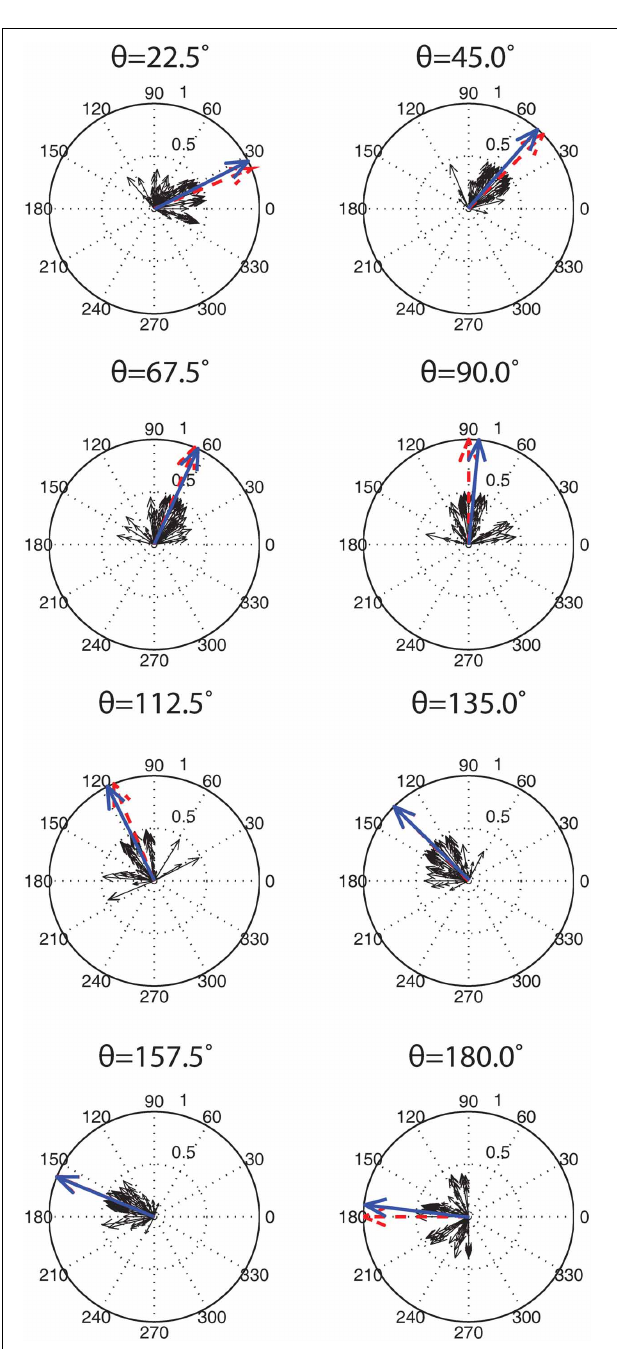
FIGURE 10 | Population decoding of eight test presentation angles. The test presentation angle θ , is shown above each population decoding figure. 100 simulation runs, each with identical parameter values but different training presentation orders, were conducted and the firing rates of the Exc group neurons were recorded. The individual responses of each of the 400 neurons (4 Exc neurons × 100 runs) are shown with solid black arrows. These individuals were summed to give a population vector (shown with a blue arrow) that was compared to the correct presentation angle (shown with a red arrow). Both the population vectors and correct presentation angle vectors were normalized while the component vectors were scaled down by a factor of 2 for display purposes (see text for